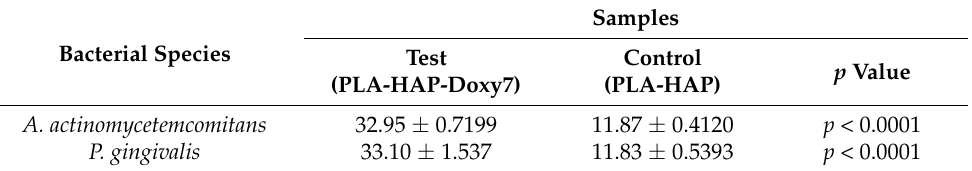
Table 2. Mean values of inhibition zone diameters (expressed in mm ± SD—standard deviation) for the tested biomaterial samples on A. actinomycetemcomitans and P. gingivalis . Samples Bacterial Species Test Control (PLA-HAP-Doxy7)